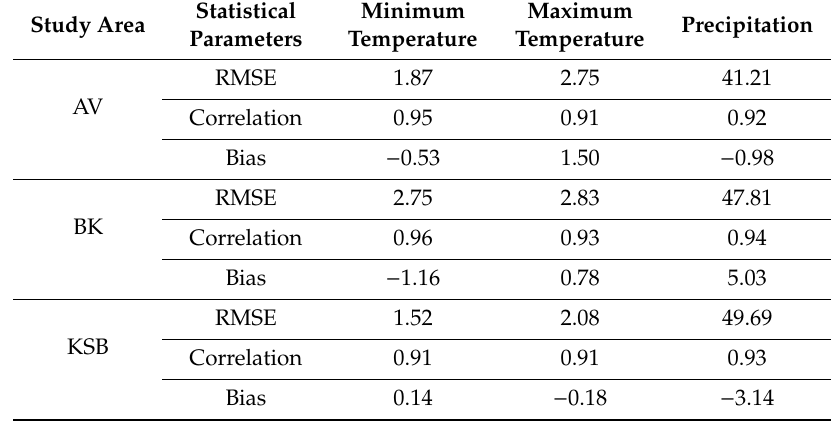
Table 3. Statistical parameters for each variable for each study area.